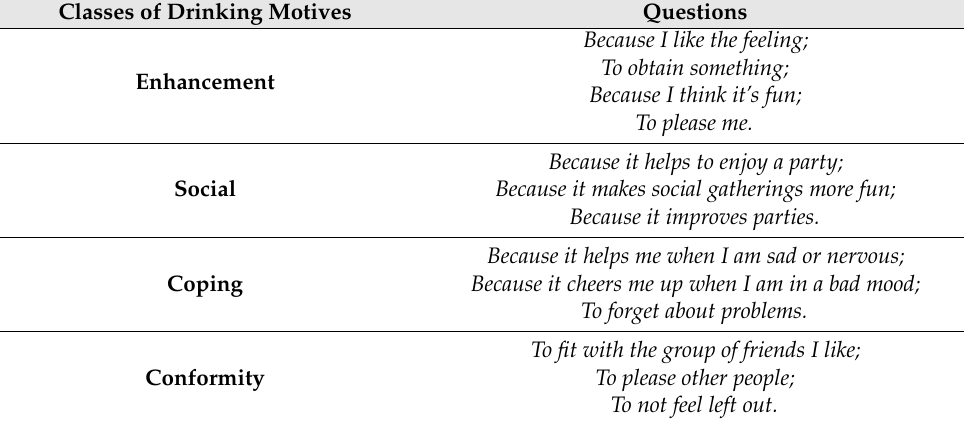
Table 1. Classes of Drinking Motives and